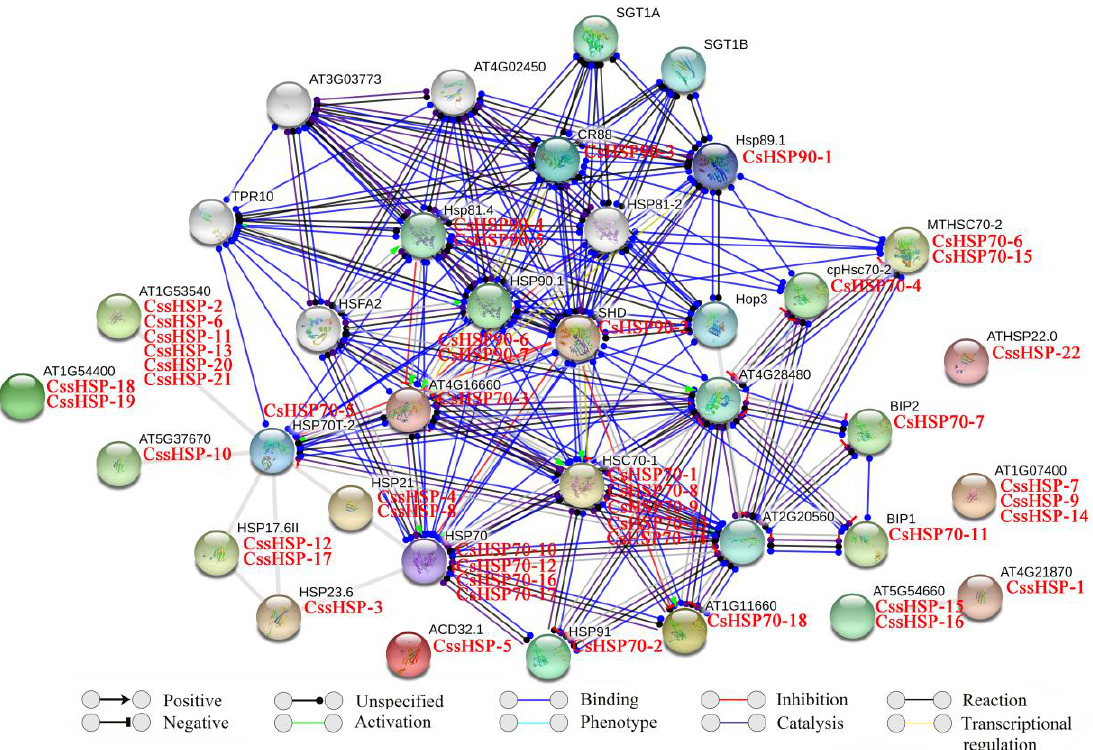
Figure 5. Putative interaction network of CsHSPs in tea plant. Homologous proteins in tea plant and Arabidopsis are shown in red and black, respectively.